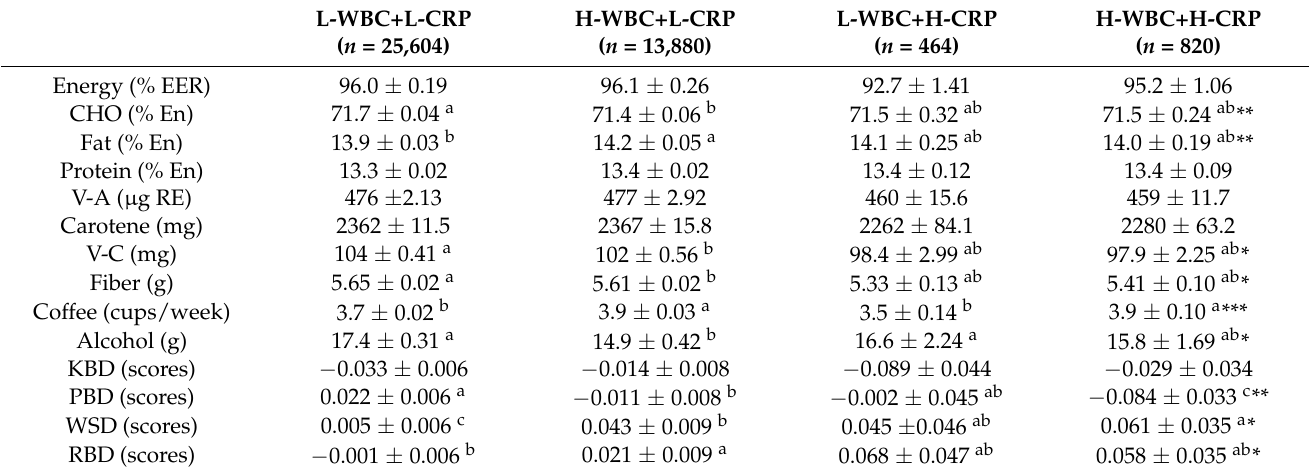
Table 4. Daily nutrient intake and dietary pattern scores according to the immunity